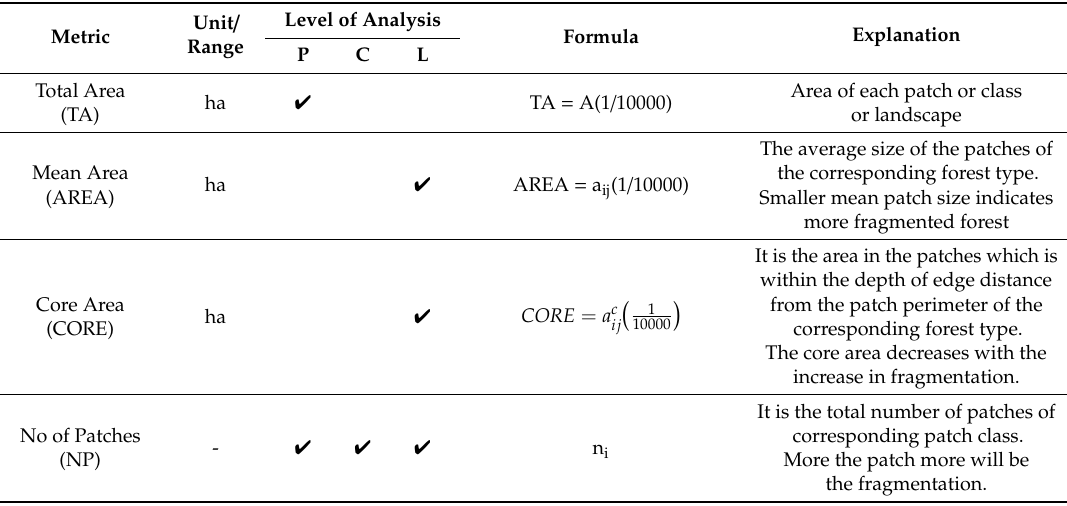
Table 1. Description of metrics computed in the present study at di ff erent